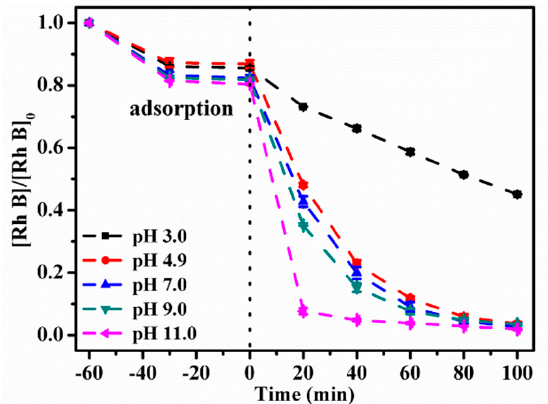
Figure 9. [Rh B] / [Rh B] 0 as a function of time with the di ff erent pH conditions in the presence of 1 g / L Figure 9. [Rh B]/[Rh B] 0 as a function of time with the different pH conditions in the presence of 1 g/L of the Cu / Al 2 O 3 / CN composite. Reaction conditions: [Rh B] 0 = 20 mg / L, [H 2 O 2 ] 0 = 10 mM, V = 100 mL, of the Cu/Al 2 O 3 /CN composite. Reaction conditions: [Rh B] 0 = 20 mg/L, [H 2 O 2 ] 0 = 10 mM, V = 100 mL, T = 25 ◦ T = 25 °C.